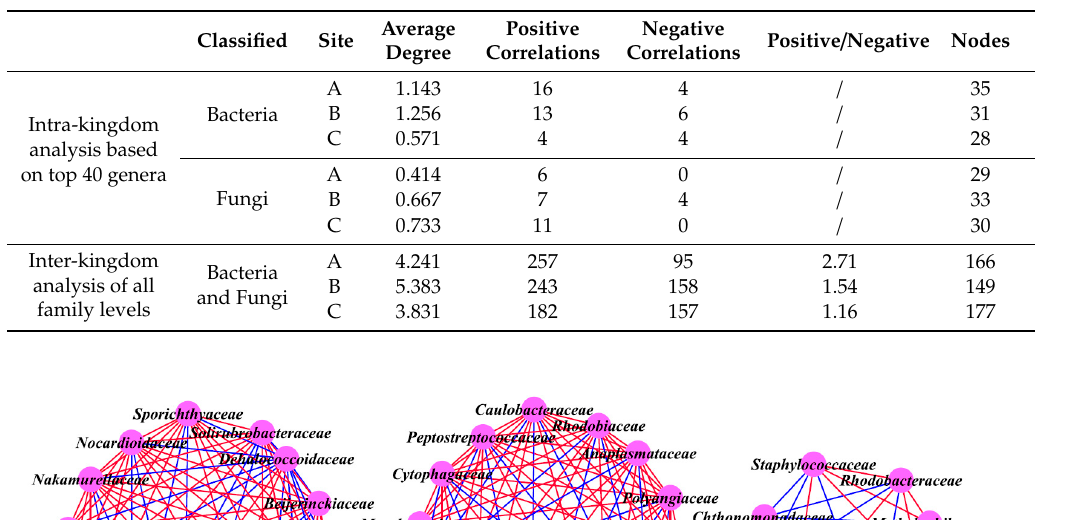
Table 5. Intra-kingdom and inter-kingdom analysis of soil microbial communities.